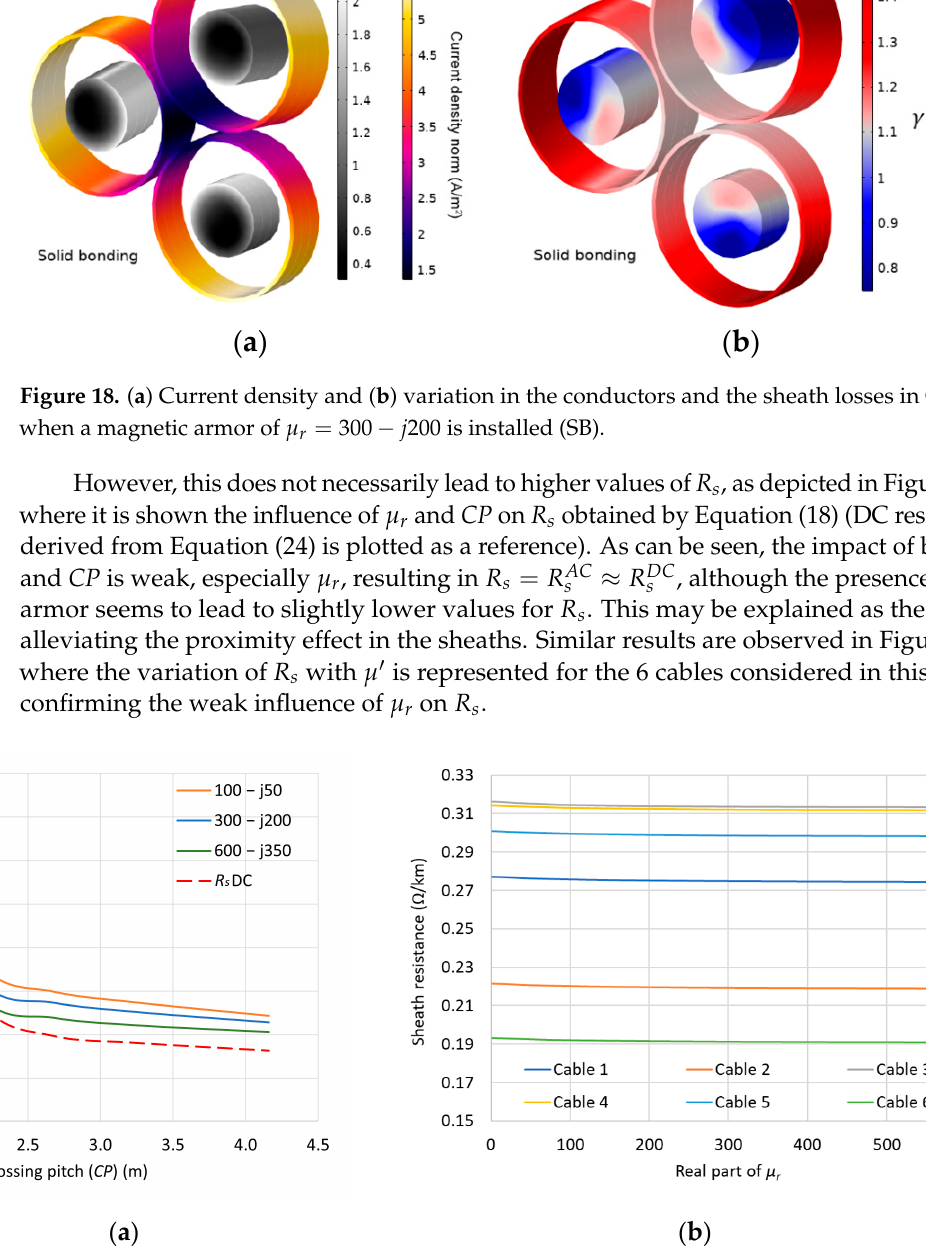
17 of 23 Figure 17. Variation of I s with CP and µ r for Cable 6 (SB) (actual CP 6 of cable included as a refer- ence). Therefore, both R s and X s are also affected by all these aspects. Furthermore, the prob- lem is even more complicated since the induced currents are non-uniformly distributed